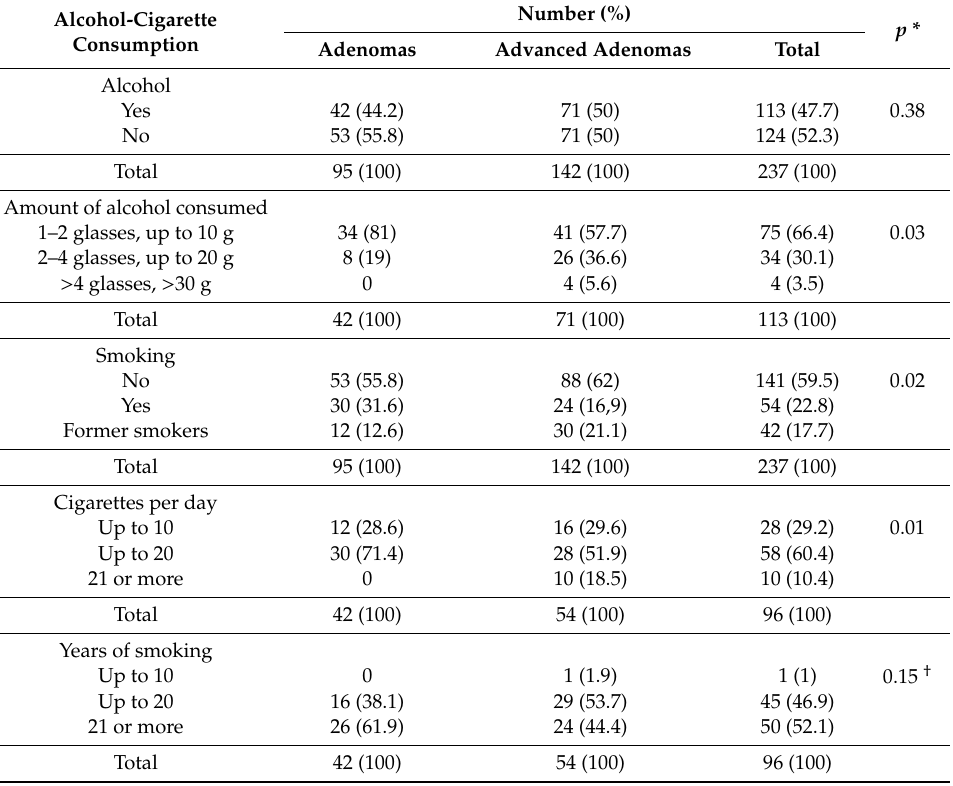
Table 6. Comparison of habits in participants with adenomas and advanced adenomas—alcohol and cigarette